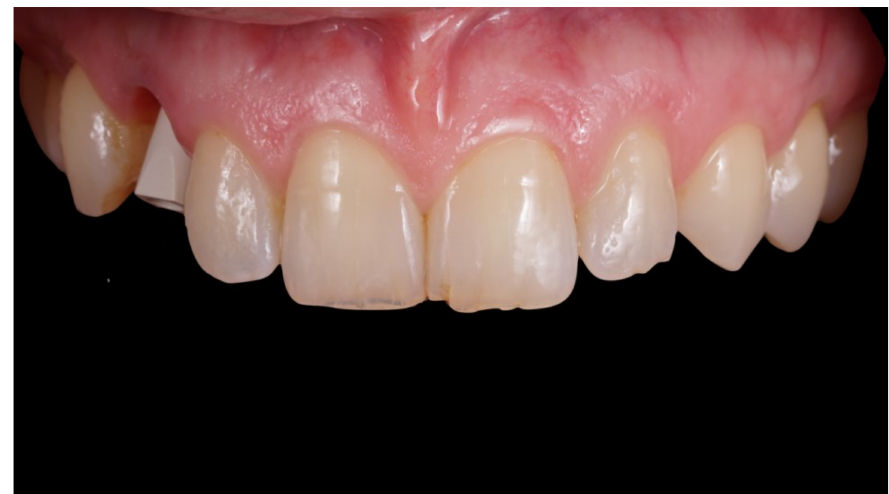
Figure 7. Scan abutment in position to record intraoral scan.